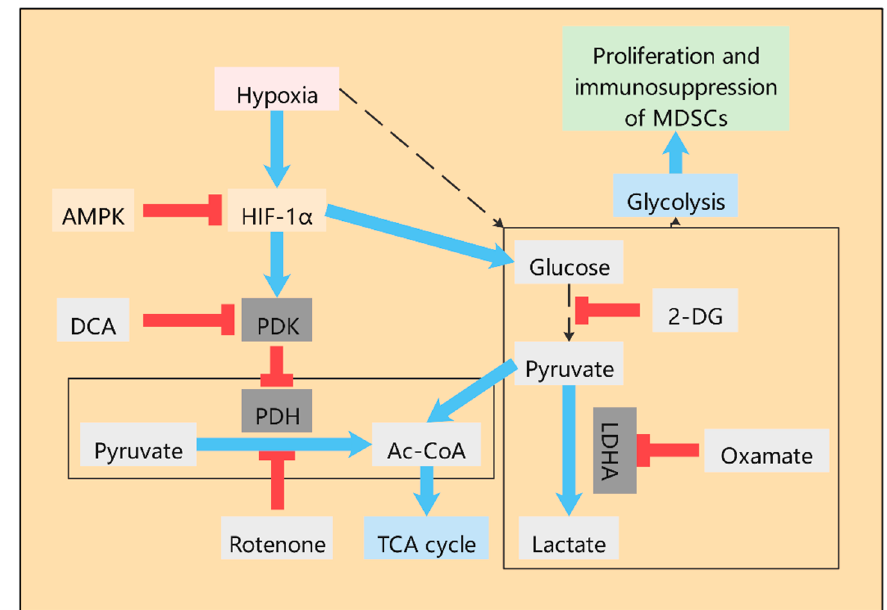
Figure 1. Glucose metabolism in myeloid-derived suppressor cells (MDSCs) . High level of glycolysis exists in MDSCs in tumor microenvironment (TME), which contributes to the accumulation of MDSCs in tumor hosts and the play of immunosuppressive activity. As an important product of glycolysis, lactate plays an important role in the TME, which can stimulate the immunosuppressive properties of MDSCs. The non-metabolizable analogue of glucose, 2-deoxyd-glucose (2-DG), inhibits the production of lactate. Oxamate inhibits LDHA directly and thus inhibits the production of lactate. Pyruvate was catalyzed by pyruvate dehydrogenase (PDH) to produce acetyl-CoA and enter the Krebs cycle. However, in most cancers, pyruvate dehydrogenase kinase (PDK) is activated and leads to selective inhibition of PDH, resulting in pyruvate being unable to enter the TCA cycle and continuing along the glycolytic pathway to eventually convert to lactate. Dichloroacetic acid (DCA) is an effective inhibitor of PDK, which can promote pyruvate into the TCA cycle and thus reduce the lactate level. Rotenone directly inhibited PDH to reduce the production of acetyl-CoA, which indirectly promoted the production of lactate. The glycolytic pathway of MDSCs is regulated by HIF-1 α and enhances the immunosuppressive function of MDSCs through HIF-1 α . AMPK activation can inhibit HIF-1 α .